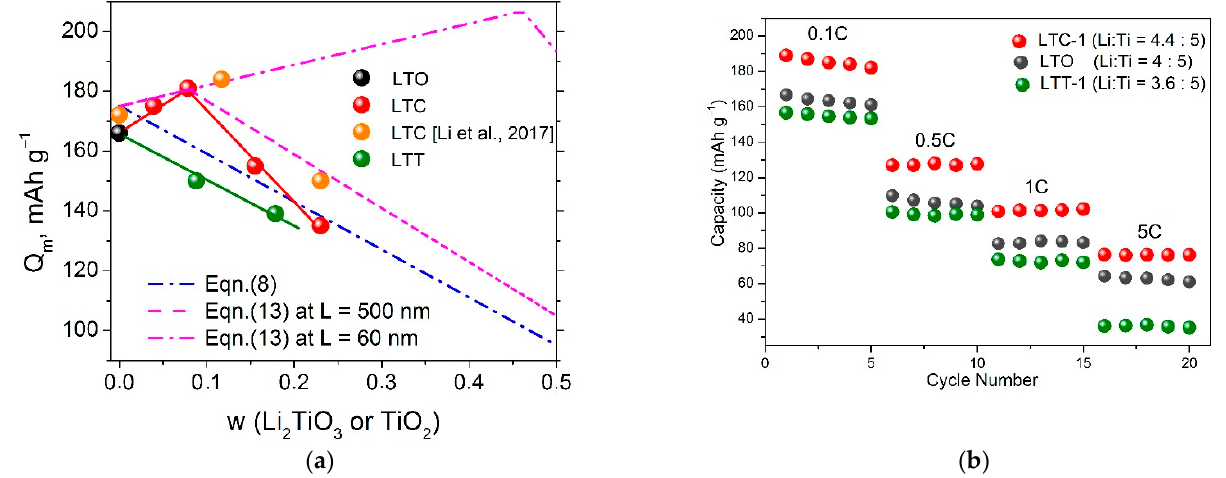
Figure 6. The variation of the discharge capacity as a function of the mass fraction of the additive ( a ) and the discharge rate ( b ) in LTC and LTT composites. Points are experimental values obtained at the rate of 0.1C in the present work (black, magenta and green points for LTO, LTC and LTT composites, respectively) as well as data (orange points) reported earlier for LTC composites in the paper [23]. Red and green lines are guides for eyes to visualise experimental data for LTC and LTT composites. Blue line corresponds to the theoretical dependences obtained from Equation (8) and magenta lines were obtained using Equation (13) for two values of the LTO grain size: L = 500 nm or 60 nm with parameters λ = 6 nm, Q 0 = 175 mAh g − 1 , Q 0 = 15 mAh g − 1 and Q 0 = 244 mAh g − 1 2 S 1